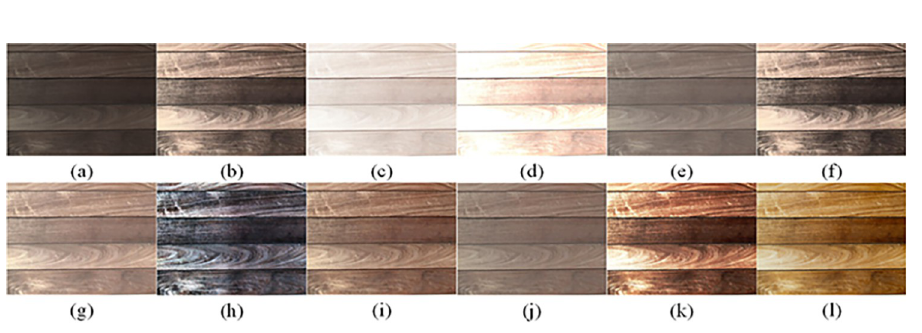
Fig 22. Comparisons of the ten algorithms in enhancing low-light image 12. (a) low-light image (b) AGCWD (c) Al-Ameen (d) BHE2PL (e) BIMEF (f) BPDHE (g) LIME (h) MSRCR (i) NPEA (j) SRIE (k) OURS (l) Normal light